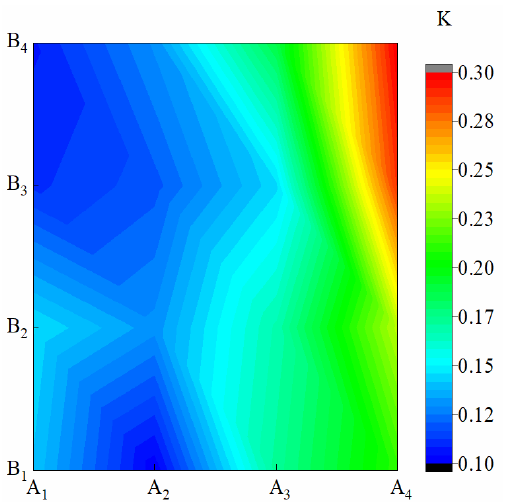
Figure 4. Release rate of membrane materials under different ratios of water-based copolymer and zeolite amounts.